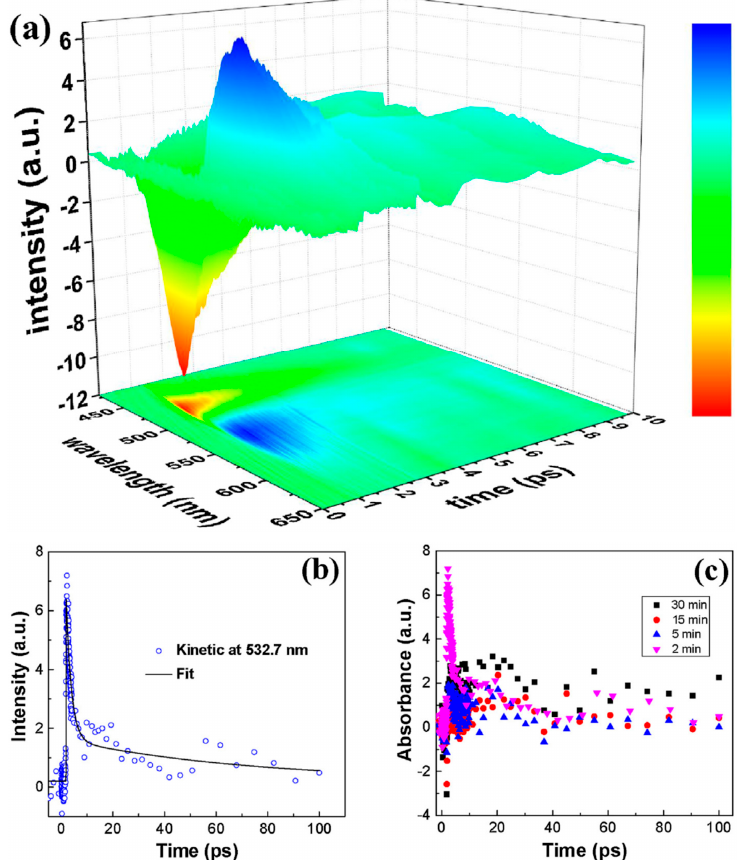
Figure 6. ( a ) The 3D ultrafast transient absorption spectrum of AgNPs-TiO 2 film which is synthesized within 2 min, and ( b ) fitted 532.7 nm. ( c ) The ultrafast transient absorption spectra at 532.7 nm for AgNPs-TiO 2 film hybrids with different synthesized time [109].